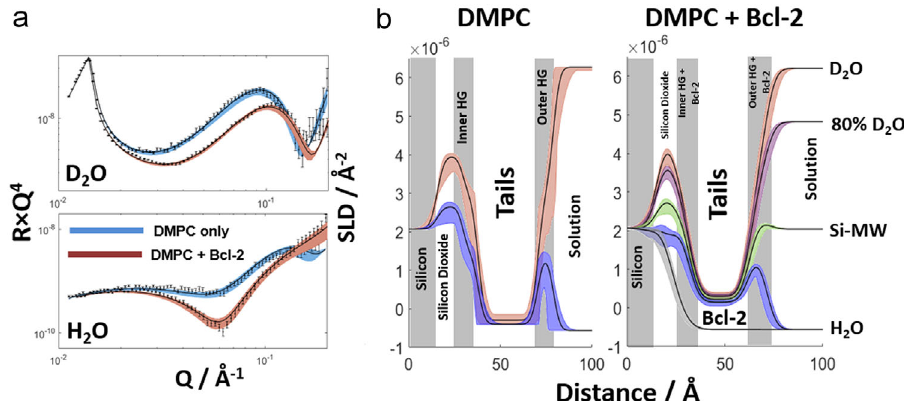
Fig. 2 Neutron re fl ectometry (NR) derived membrane pro fi les in the presence of Bcl-2 protein. Experimental NR pro fi les (error bars) and model data fi ts (lines) obtained for a fully deuterated Bcl-2:fully protonated-DMPC (at a 70:1 lipid-to-protein molar ratio) supported lipid bilayer under multiple solution isotopic contrast conditions. Re fl ectivity pro fi les are shown in Re fl ectivity × Q 4 to highlight features in the data arising from the interfacial structure. a Comparison of experimental datasets and model-to-data fi ts for DMPC bilayers with and without Bcl-2, where the SLD (scattering length density) contrast between the solution and the lipid and protein components was highest (in the presence of D 2 O and H 2 O buffers, respectively). The results highlight the effects of the presence of Bcl-2 in the bilayer on the experimental re fl ectivity pro fi les and subsequent model-to-data fi ts. b Scattering length density pro fi les obtained from all solution isotopic contrast model-to-data fi ts for the DMPC only (left) and the composite DMPC Bcl-2 membrane (right) datasets. Line widths in both the fi ts and SLD pro fi les represent the 95% con fi dence intervals obtained by MCMC (Markov Chain Monte Carlo) sampling of the model-to-data fi ts. Overview of results of all NR experiments with varying isotopic contrast conditions and the full set of analyzed data are shown in Supplementary Figs. 1, 2.